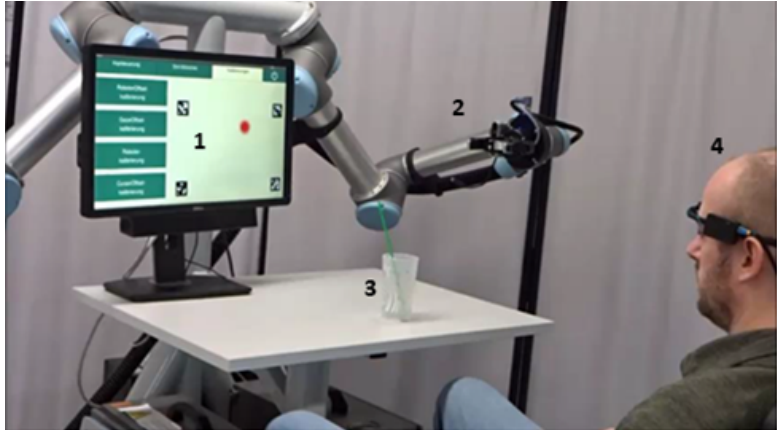
Figure 5. Experimental setup of use-case scenario with GUI to select the buttons (1), robot arm with gripper (2), cup with straw (3), and subject with the multimodal control unit